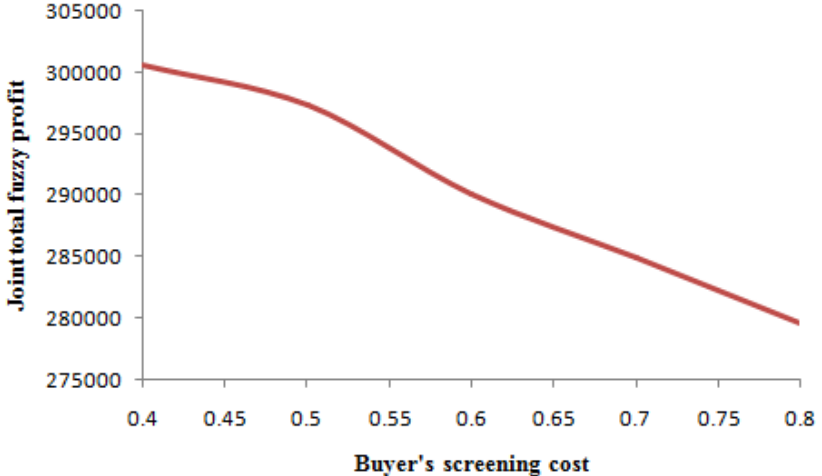
Figure 17. Energy cost of production vs. the joint total fuzzy profit.